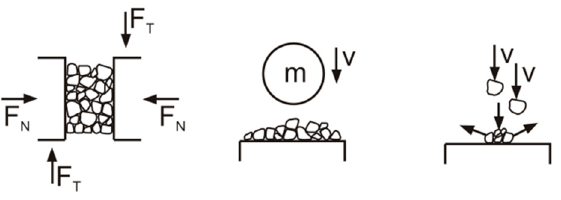
Figure 1. Three types of interactions between mineral particles and grinding components, F n —normal force, F t —tangential force, m—mass, v—speed.